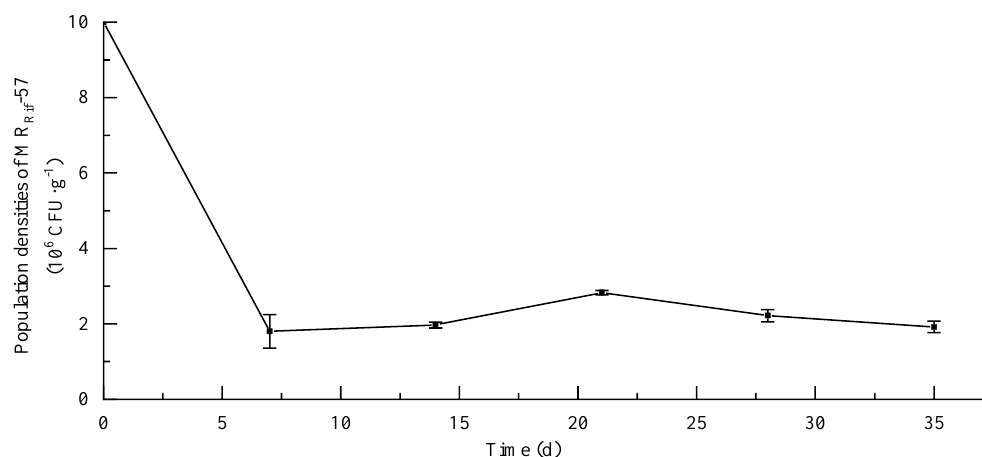
Figure 6. Time course of MR Rif -57 colonization in the soil in which S. divaricata was grown. Soil samples were treated with a spore suspension of MR Rif -57 at a final density of 10 7 CFU · g − 1 of soil. After 7, 14, 21, 28, and 35 days of inoculation, the population densities of the MR Rif -57 were determined.